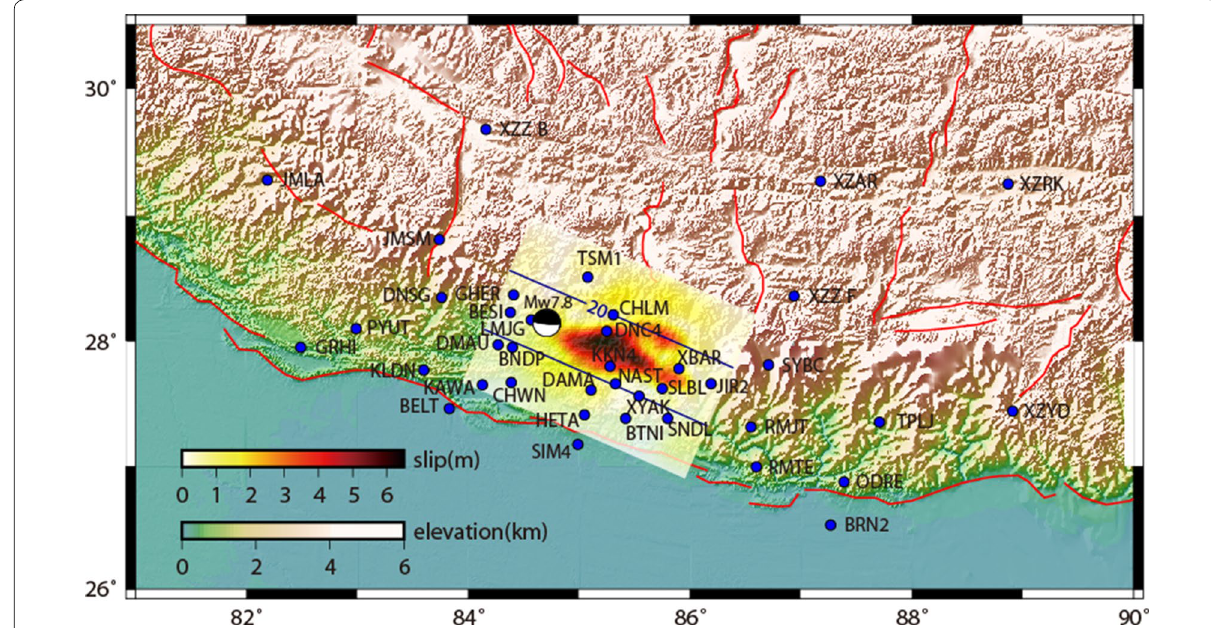
Fig. 1 Tectonic setting. The black beach ball shows the mainshock focal mechanism from U.S. Geological Survey. The blue circles are continuous GPS sites used in this study. The color represents the topographical relief, and the color of overlapped fault plane represents the coseismic slip distribution from Tung and Masterlark (2016). The black lines mark the depth of faulting. The red lines represent active faults from Taylor and Yin (2009). The Figure was generated by GMT software (Wessel et al.